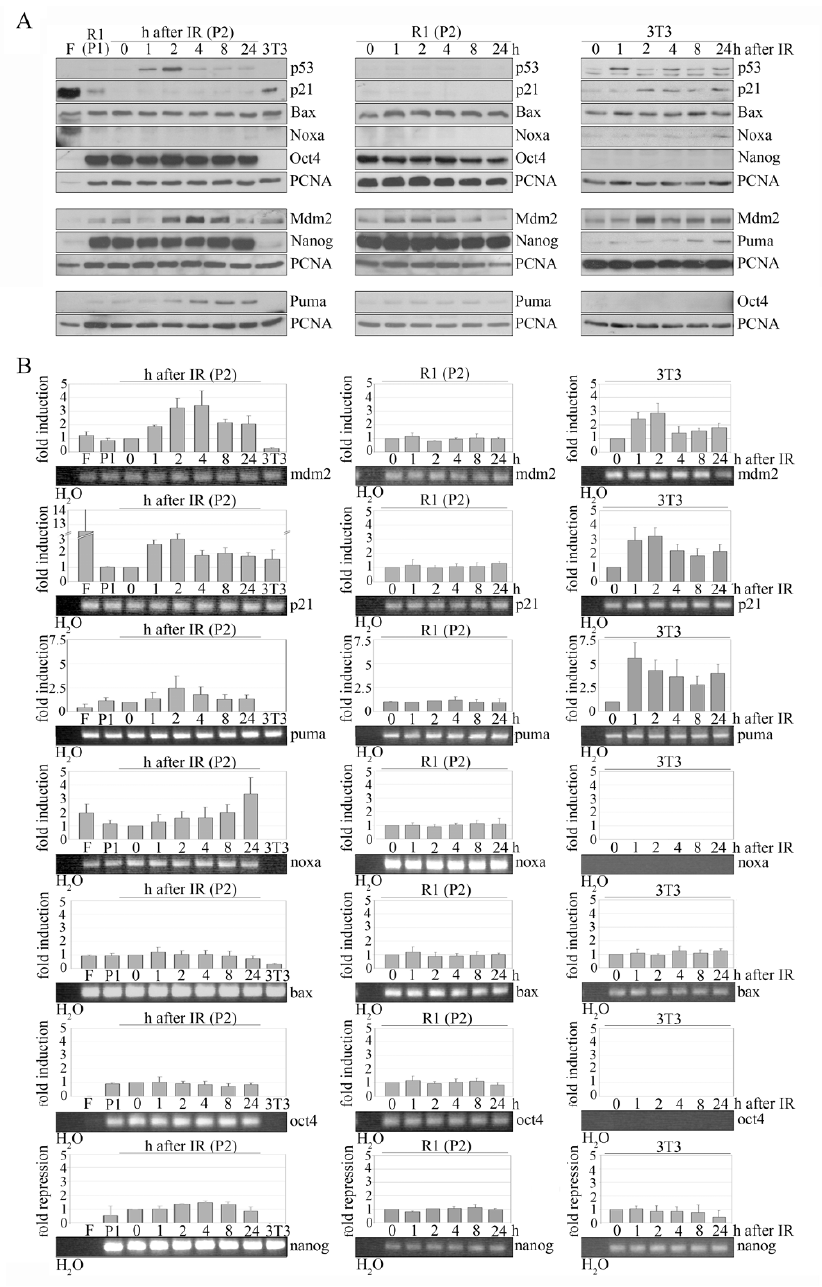
Figure 3 p53 is activated in ES cells after IR . R1 stem cells passaged once (P1) or twice (P2) without feeders and 3T3 mouse fibrob- lasts were irradiated with 7.5 Gray or left unirradiated. Cells were harvested at the indicated times and divided into two aliq- uots. One of the aliquots was used to determine the amount of protein (A) and the second aliquot (B) to monitor the abundance of corresponding RNAs. (A) Western Blots showing p53, p21, Bax, Noxa, Mdm2, Puma, Oct4, Nanog and PCNA (proliferating cell nuclear antigen) for loading control. (B) Real time PCR for mdm2 , p21 , puma , noxa , bax , oct4 and nanog RNA. Mean values and standard deviations were calculated from the obtained 2^dCT numbers of qRT-PCR signals of 3–6 independ- ent experiments and blotted. Values of non-irradiated P2 cells at time point "0" and non-irradiated 3T3 cells, respectively, were set to 1. The quality of the qRT-PCR products was controlled by agarose gel electrophoresis. A representative picture of the gel is placed below the